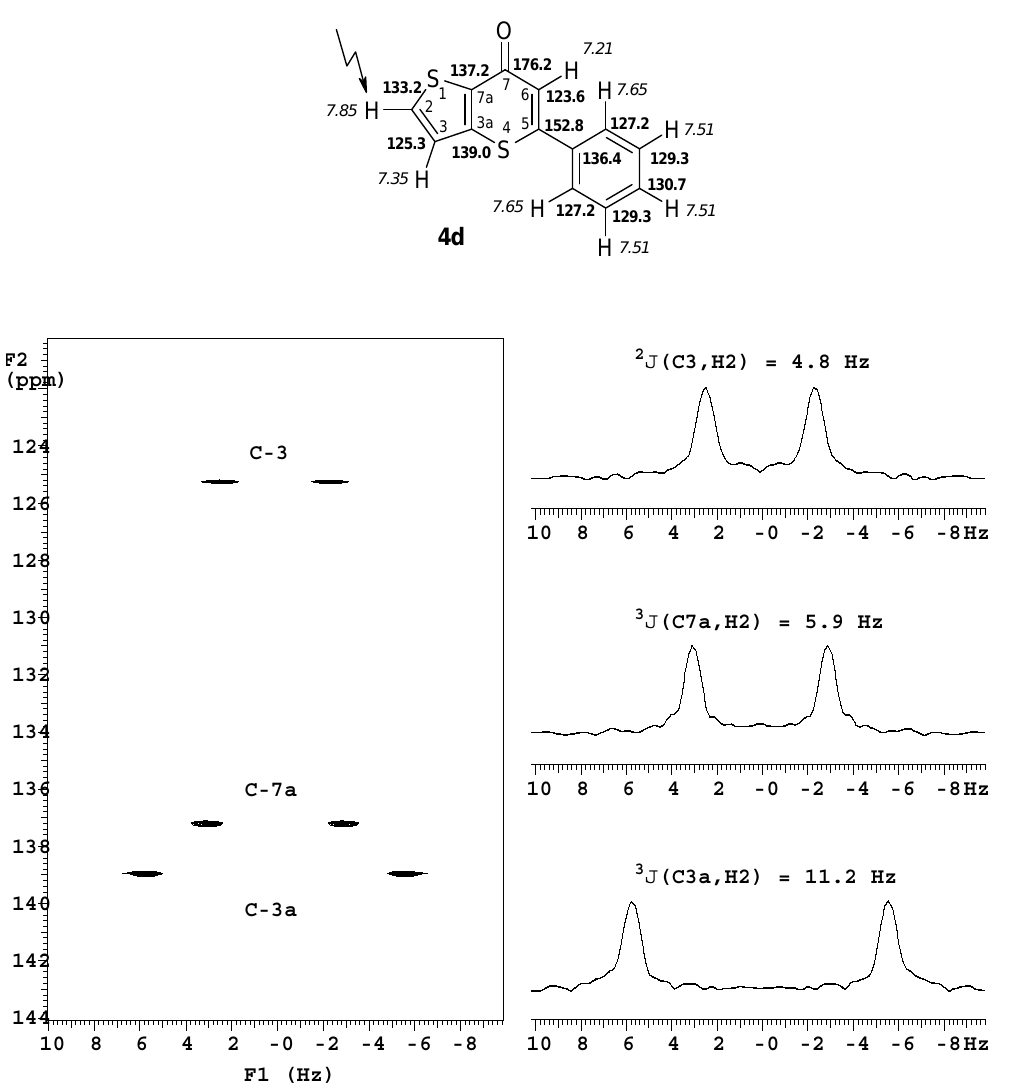
Figure 2. Part of the long-range 2D ( δ , J ) INEPT spectrum of 4d obtained upon selective excitation of the H-2 resonance; 1 H- (in italics ) and 13 C-NMR chemical shifts in